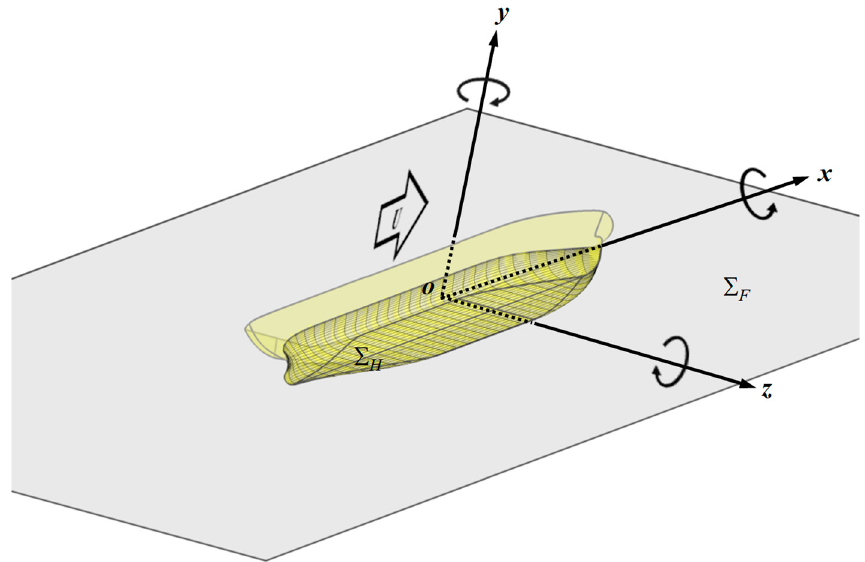
Figure 1. Coordinate system.